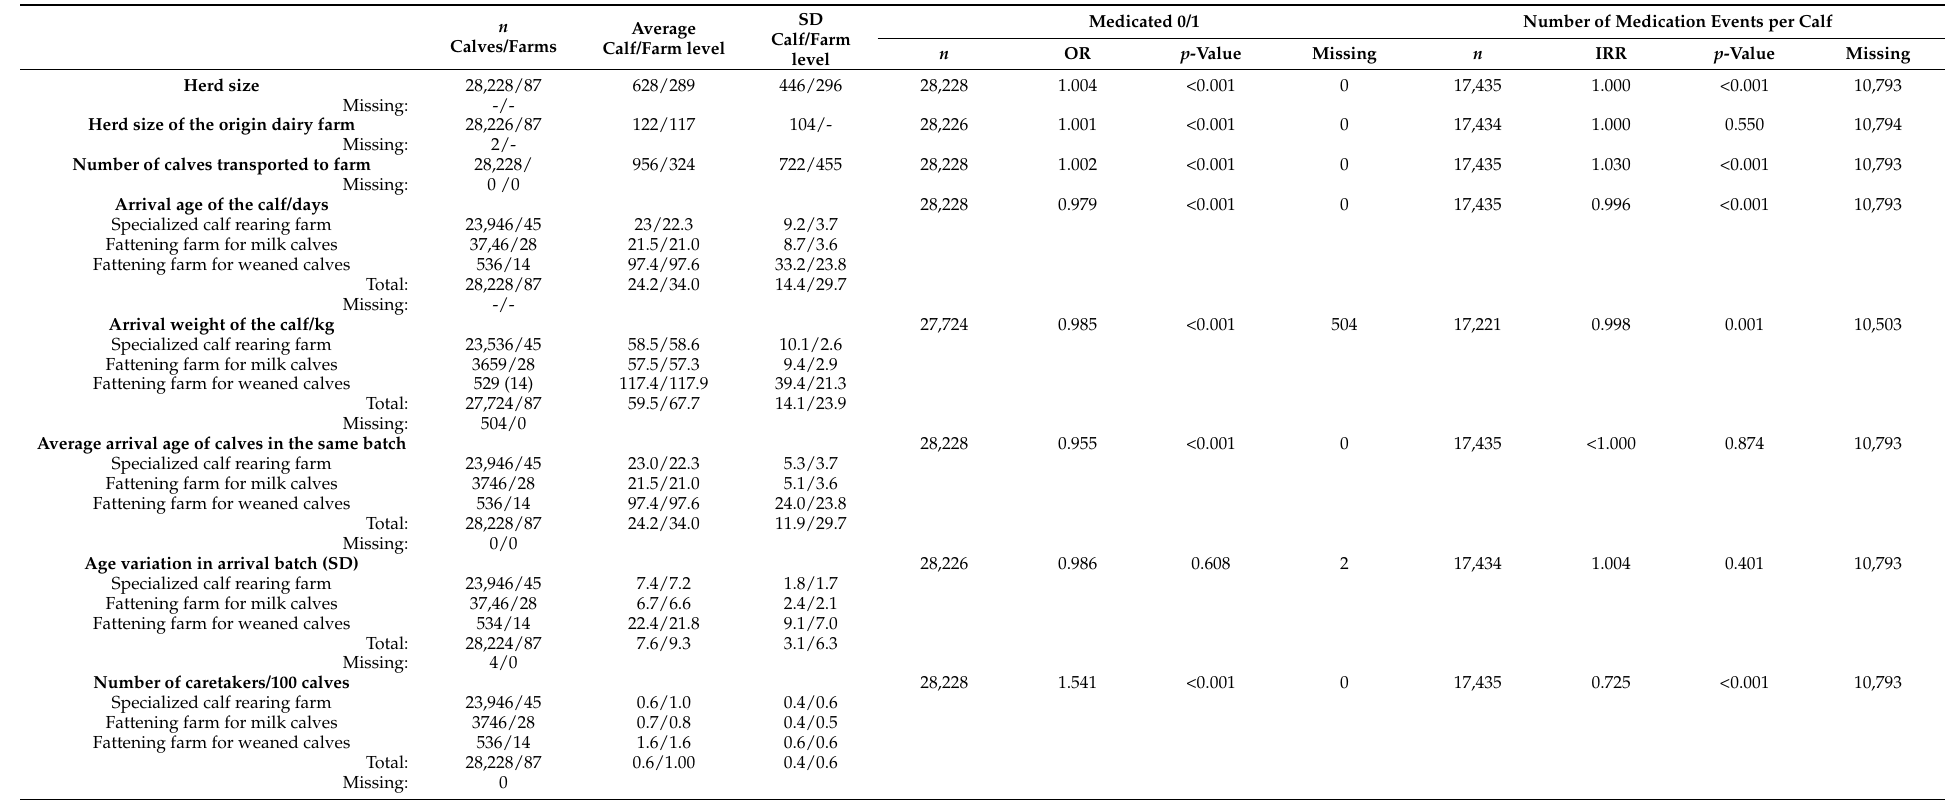
Table 5. Descriptive statistics of continuous variables of 28,228 calves and univariate associations of predictor and outcome variables. Study included 23,946 calves reared in 45 specialized calf rearing farms, 3746 calves reared on 28 fattening farms for milk calves and 536 calves reared in 14 fattening farms for weaned calves. Daily gain was calculated for calves with two weight